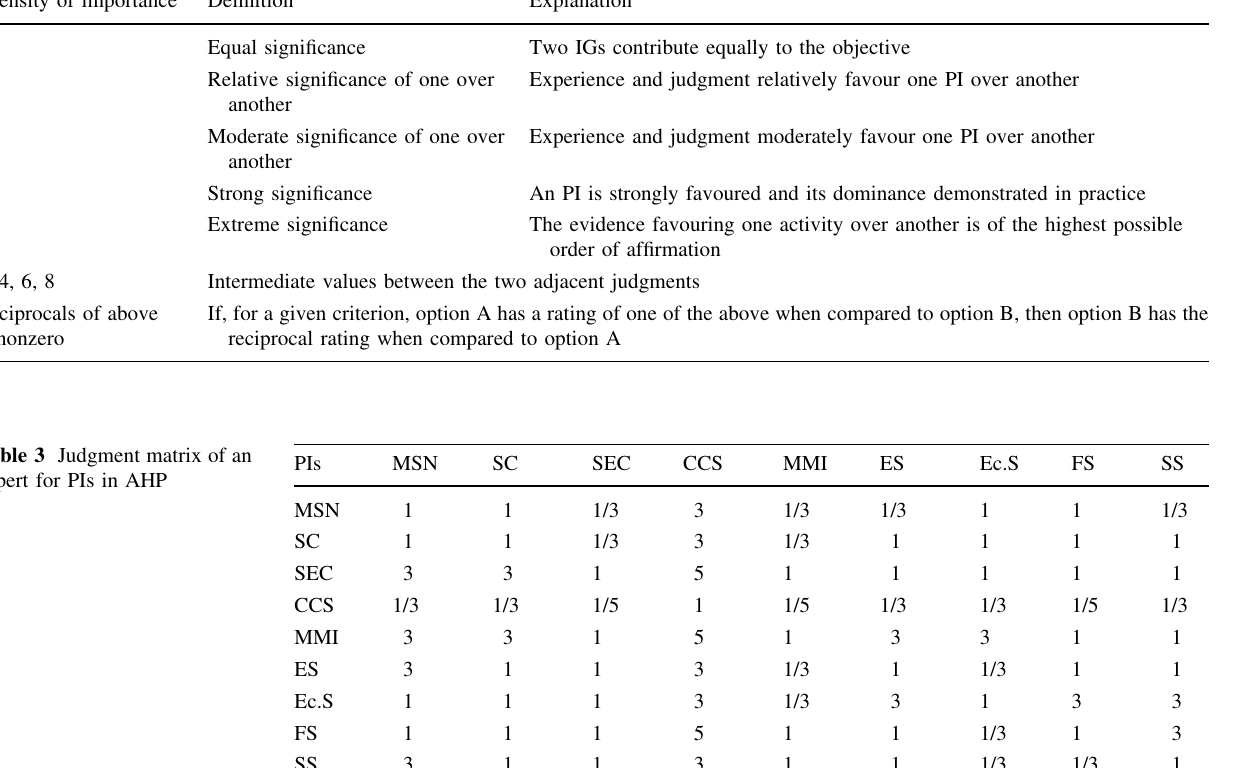
Table 2 Illustrative criterion matrix for pairwise comparison using AHP. Source : Saaty [41] Intensity of importance